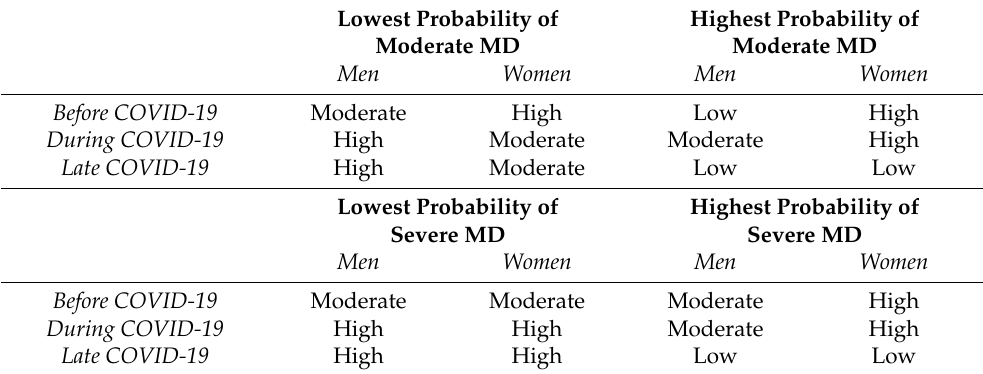
Table 14. Predictive probabilities of moderate and severe mental distress levels by physical exercise frequency and COVID-19 era during weekdays among men and